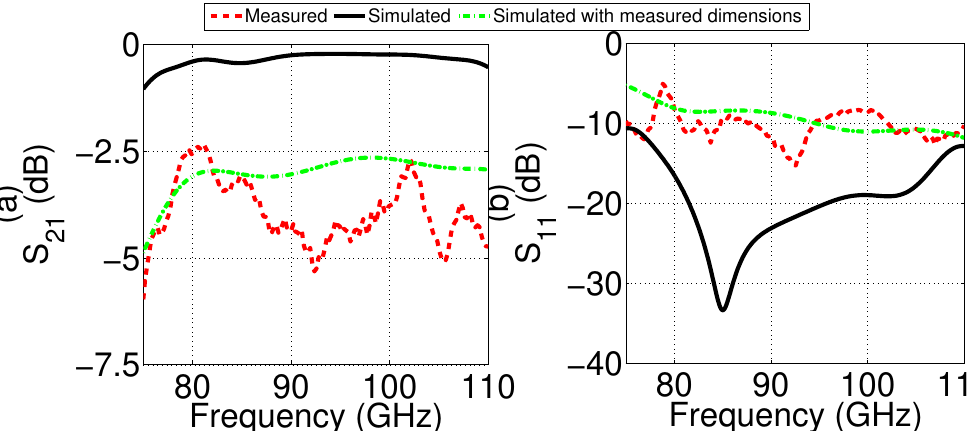
Figure 12. Comparison between predicted response (black solid line), simulated transition taking into account the fabricated value (green dashed-point line) with 150 µ m of misalignment and measured (red dashed line) back-to-back configuration of the second transition model prototype (Figure 1b): ( left ) insertion loss and ( right ) return